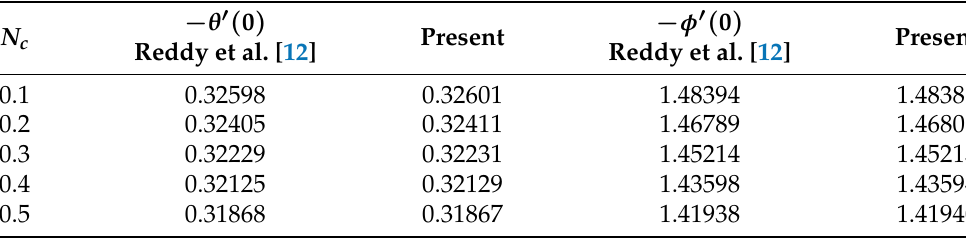
Table 2. Comparison of − θ (cid:48) ( 0 ) and − φ (cid:48) ( 0 ) by alternating buoyancy ratio parameter N c with pub- lished